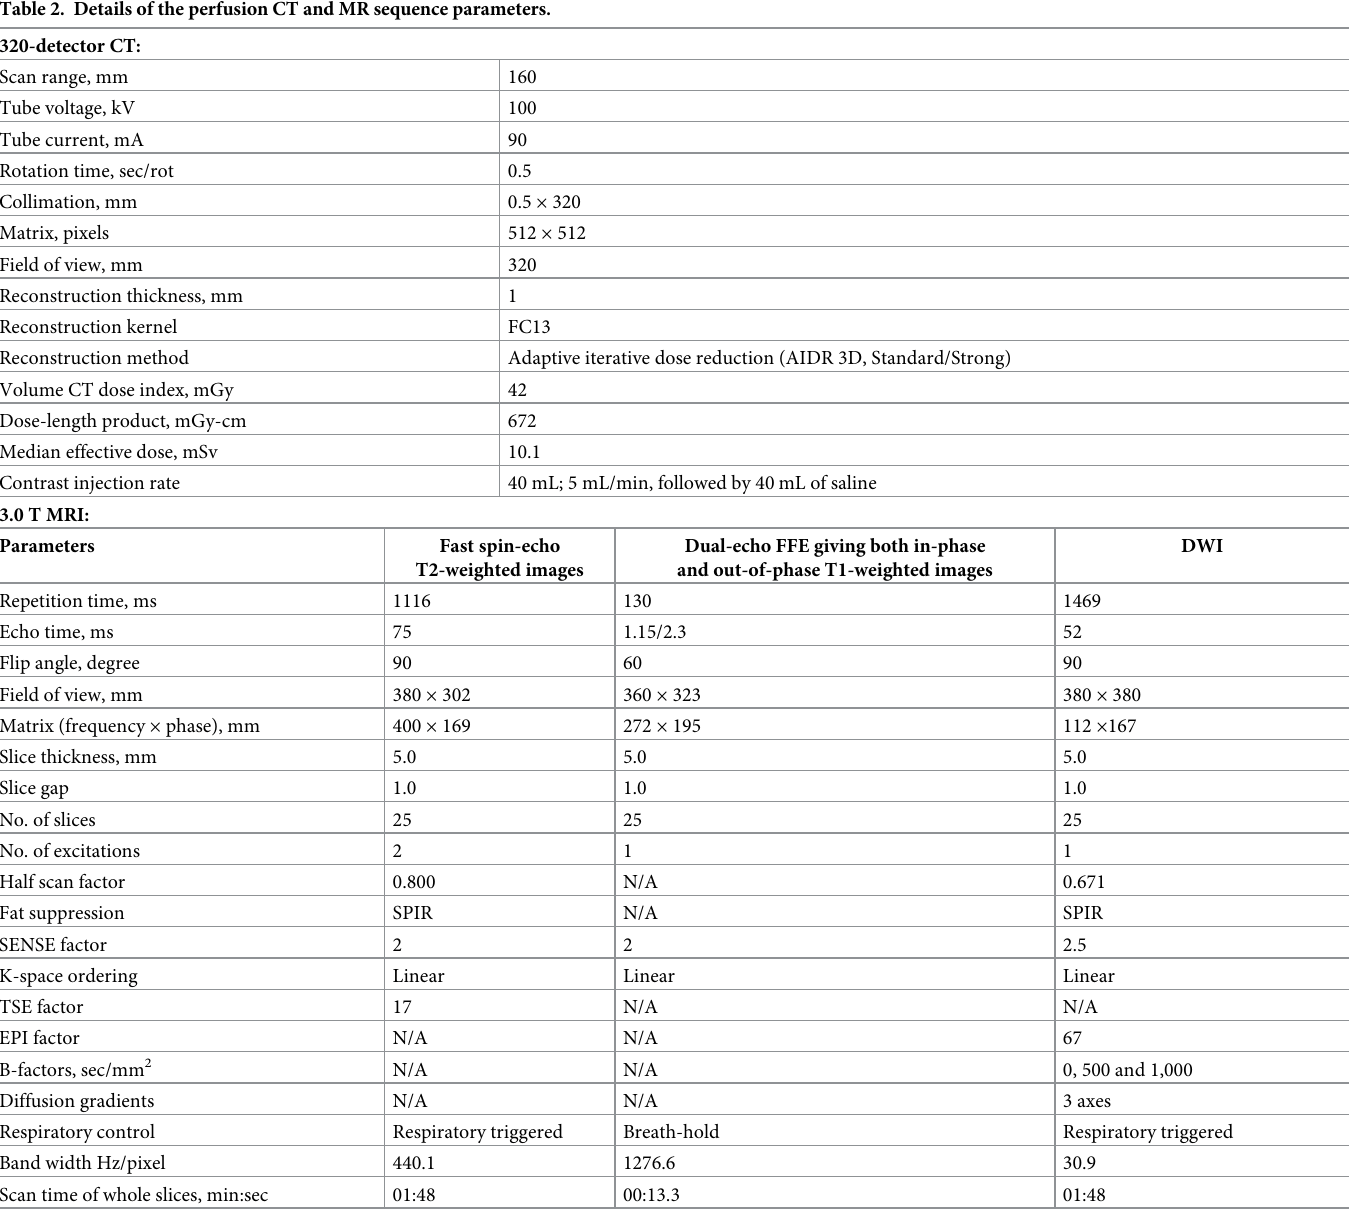
Table 2. Details of the perfusion CT and MR sequence